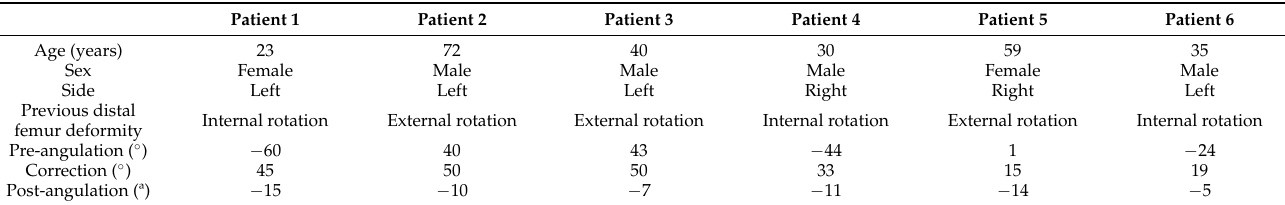
Table 1. Clinical and surgical data of the